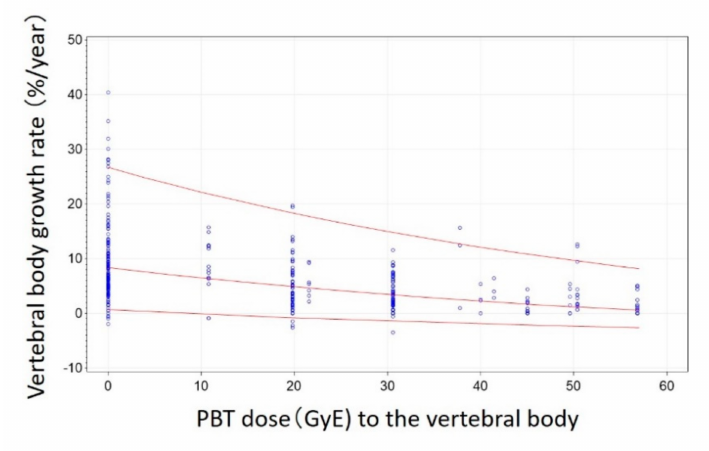
Figure 5. Scatter plot of the growth rate (%/year) of all measured vertebral bodies and proton beam therapy dose. Red lines represent 2.5, 50, and 97.5 percentile